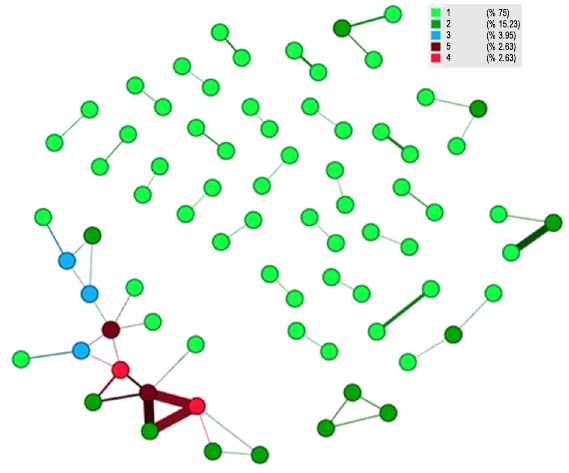
Fig. 5. CIS market network